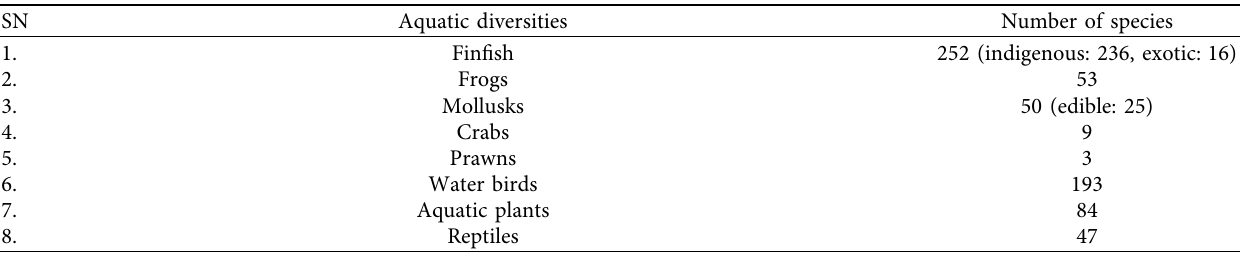
Figure 4: Number of ponds and their area from the fiscal year 2010/11 to 2020/21 in Nepal. Data obtained from [27, 28]. Table 2: Aquatic diversities in